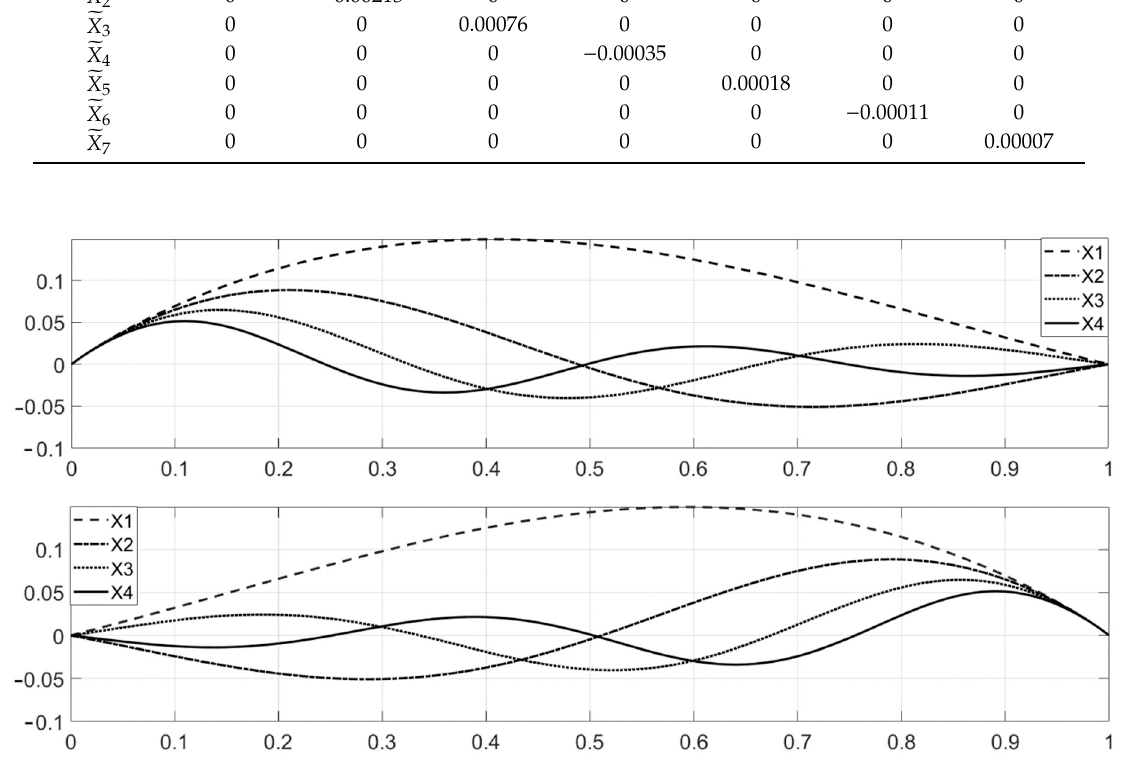
Figure 1. The first four functions, of the system (cid:4668)𝑋 (cid:3040) (𝑥)(cid:4669) (cid:3040)(cid:2880)(cid:2869);(cid:2870);… , (at the top) and (cid:4668)𝑋(cid:3560) (cid:3040) (𝑥)(cid:4669) (cid:3040)(cid:2880)(cid:2869);(cid:2870);… (at the bottom), corresponding to the case α = 1.47 and c = 1.8.